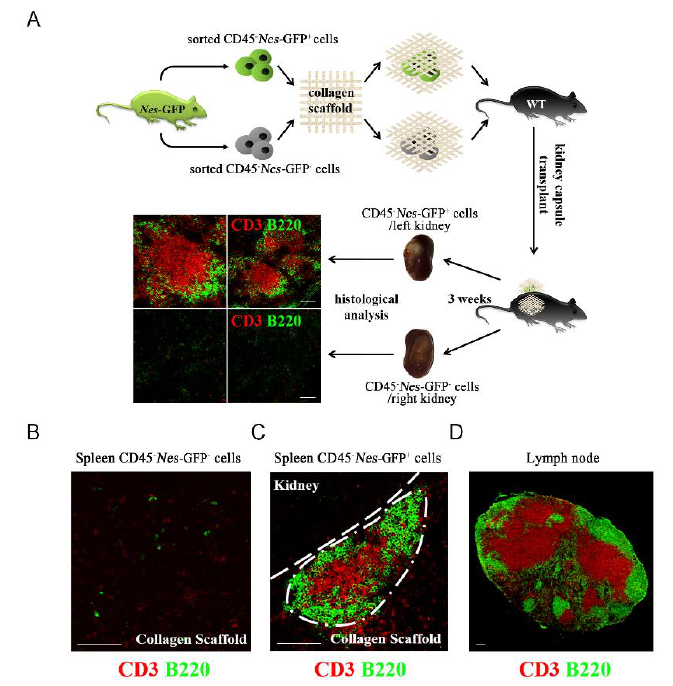
Figure 3. Spleen-derived Nes -GFP + cells could form secondary lymphoid organs. ( A ) Spleen CD45 - Nes -GFP − and CD45 - Nes -GFP + cells of Nes -GFP transgenic mice with collagen scaffolds were trans- planted into the kidney capsule of wild- type mice. Scale bars, 100 μm. ( B , C ) Representative stained images of transplants showed that Nes -GFP + cells, instead of Nes -GFP - cells, could form lymphoid tissue- like organoids. Scale bars, 100 μm. ( D ) Representative stained images of lymph node. Scale bars, 100